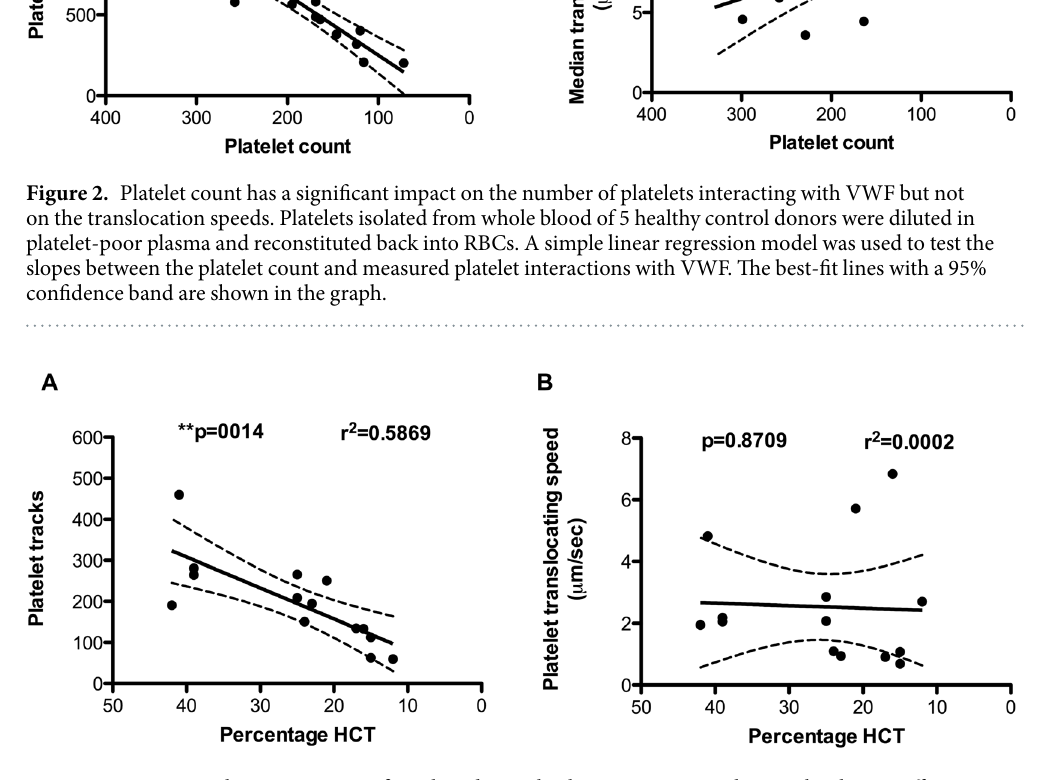
platelets translocating across and stably adhering to VWF is accompanied by a reduction in the speed of trans- location (Table 2). These changes in platelet function are not just a consequence of haemodilution but due to intrinsic changes in platelet function. The normal haemodilution associated with pregnancy is accompanied by what would appear to be a subopti- mal increase in the number of RBCs in circulation: the percentage increase in blood volume exceeds the percent- age increase in the number of RBCs 17 . It has been suggested that platelet count is reduced in pregnancy due to increased platelet turnover 18 . Indeed, our results for ex - vivo haemodilution of blood from non-pregnant donors show that reductions in either platelet count or HCT diminish the extent of platelet interactions with VWF. The effects of HCT on platelet interactions with VWF have been noted previously. Chen et al . 19 reported that the number of platelets that adhered to VWF is highly regulated by HCT and flow rate. As HCT and flow rate increased, driving platelets towards the vessel wall, there was a concomitant increase in platelet adhesion to VWF 19 . Our group more recently verified the importance of HCT and flow rate in determining initial plate- let adhesion to VWF using Stokes flow simulations and microfluidic flow experiments 16 . At arterial shear flow (1500 s − 1 ), a higher HCT was associated with greater numbers of platelet/RBC collisions. Platelet collisions with RBCs reduced the time needed for platelets to migrate through the cell-free layer towards the wall of the vessel. As more platelets presented at the vessel wall, the number of platelet interactions with VWF also increased 16 . Haemodilution is a likely cause for the reduced numbers of platelets interacting with VWF in pregnancy. However, haemodilution cannot account for reduced platelet translocation speeds on VWF during pregnancy, a reduction we found to be independent of both platelet count and HCT. These reduced translocation speeds may result from an intrinsic change in the function of platelets that occurs uniquely during pregnancy, consistent with